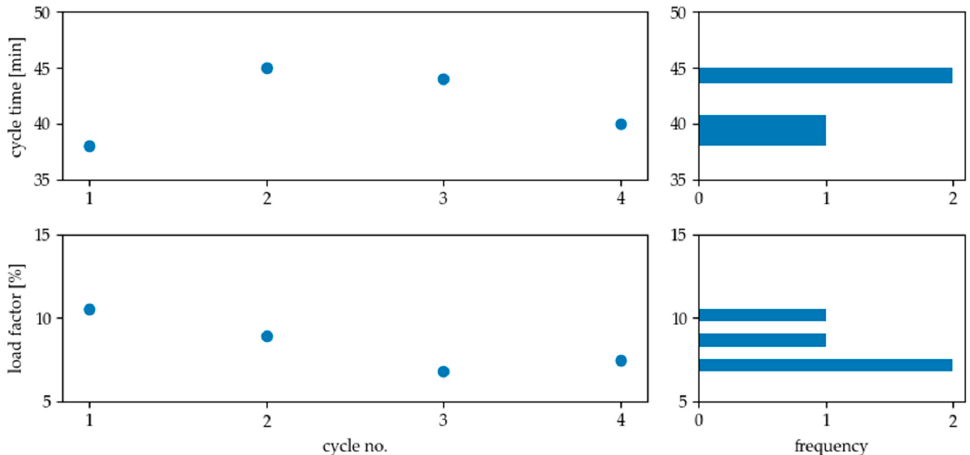
Figure 15. Result of load analysis for compressor in standby operation (4 a.m. to 7.30 a.m.). Each dot in the left pictures represents a full charging cycle. On the right side, the frequency with which the respective values occurred is shown. The resulting average cycle time is 41.75 min, the mean load factor 8.4%.